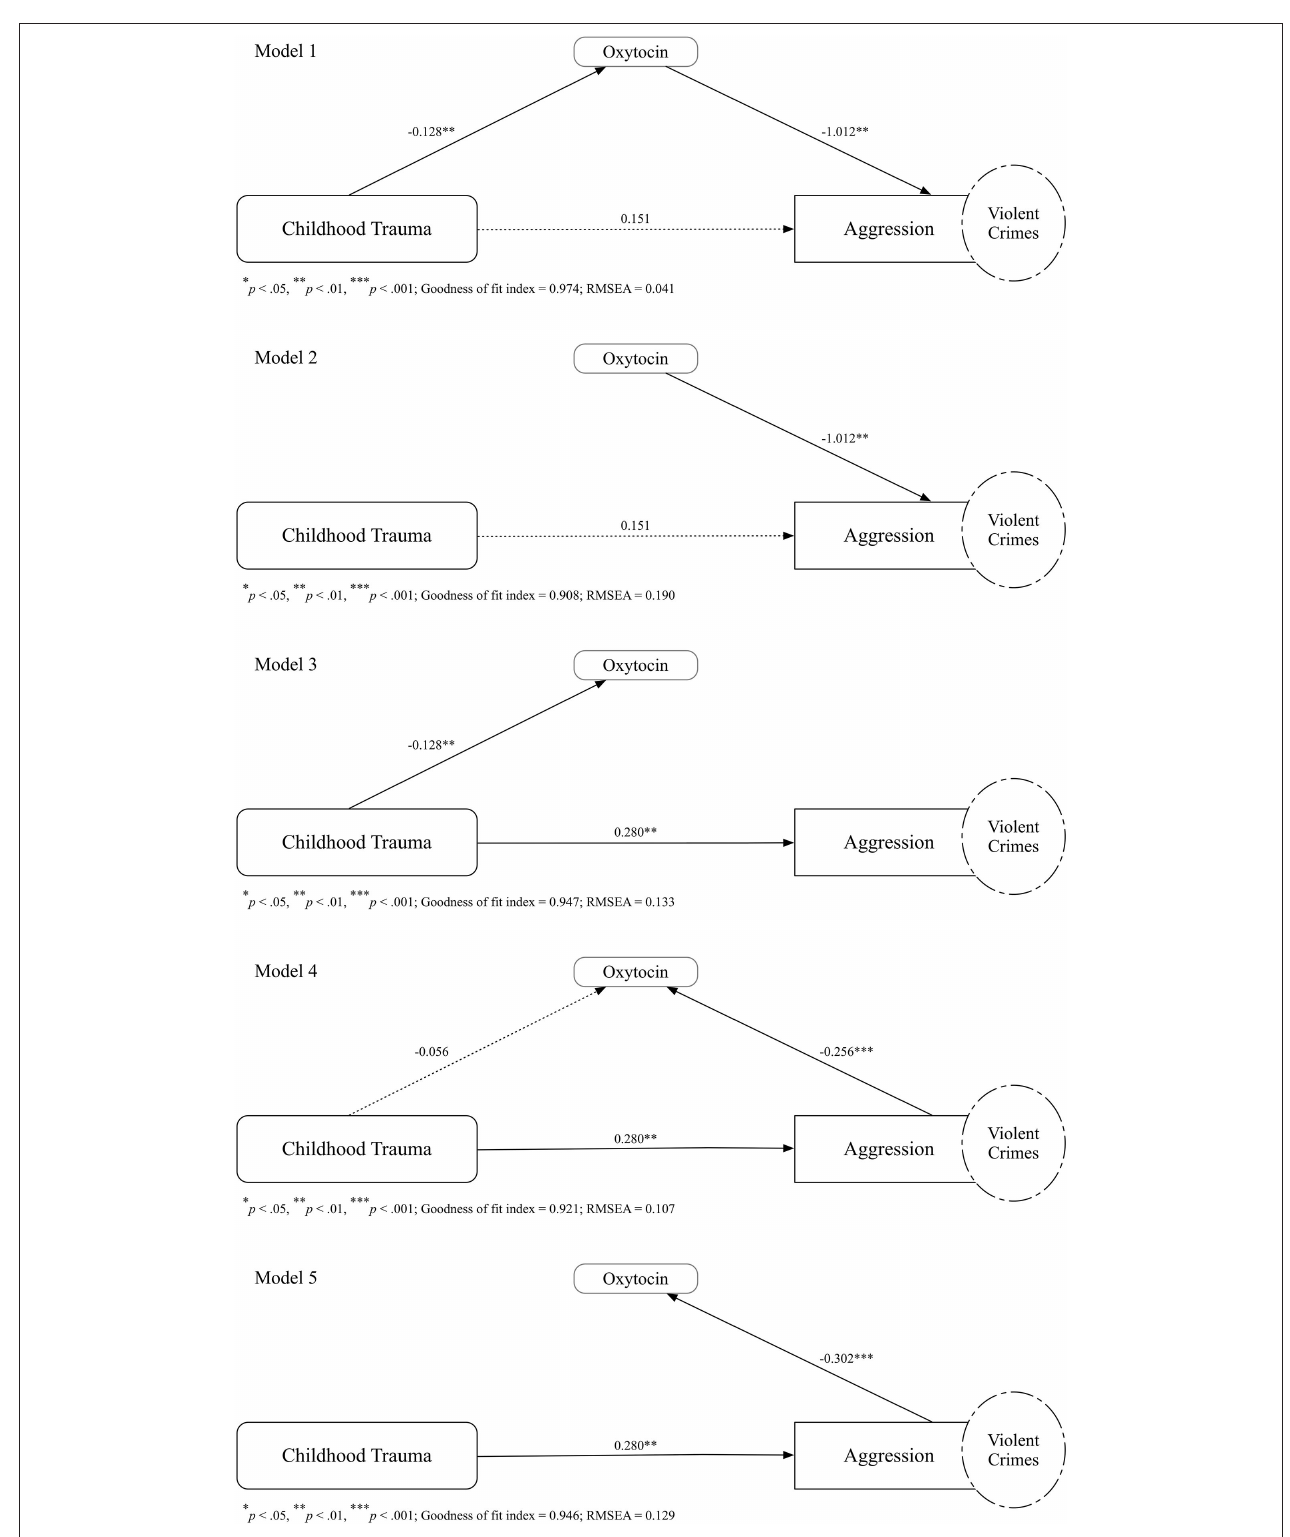
FIGURE 2 | Path diagram illustrating the unstandardized regression coefficients for the relationship between childhood trauma and aggression, as mediated by levels of plasma oxytocin in persons convicted for homicide. Several theoretical hypotheses of the relationship between childhood trauma, aggression, and plasma oxytocin levels have been postulated: (Model 1) the relationship between childhood trauma and aggression was mediated by oxytocin, (Model 2) childhood trauma and